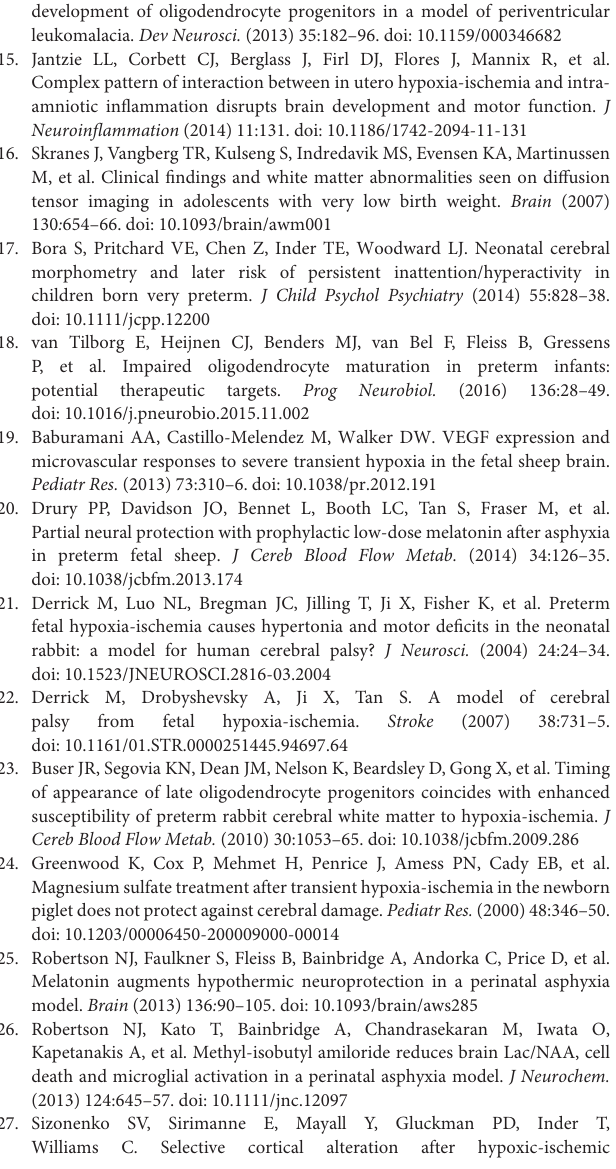
Supplementary Figure 1 | Cortical motor map by ICMS at 5 weeks of age. Cortical maps at 5 weeks of age ( n = 9 for control, n = 11 for neonatal WMI) are shown as a 5-colored code in the grid: twitch of the hip joint (red), knee joint (yellow), foot joint (light blue), and trunk (green), and non-responsive square (gray). The current threshold at each point is presented in each grid. Supplementary Figure 2 | Iba1 immunostaining. (A) Iba1 immunoreactivity was upregulated on the right H-I side of the cortex at P 17 ( n = 4). (B) Appearance of Iba-1 positive microglia was increased in the right hemisphere (R) compared with the left side (L). (C) At P 28 ( n = 4), the upregulation of immunoreactivity was not seen in either hemisphere. Error bars show 1mm (A) , and 40 µ m (B) . Supplementary Table 1 | Sholl